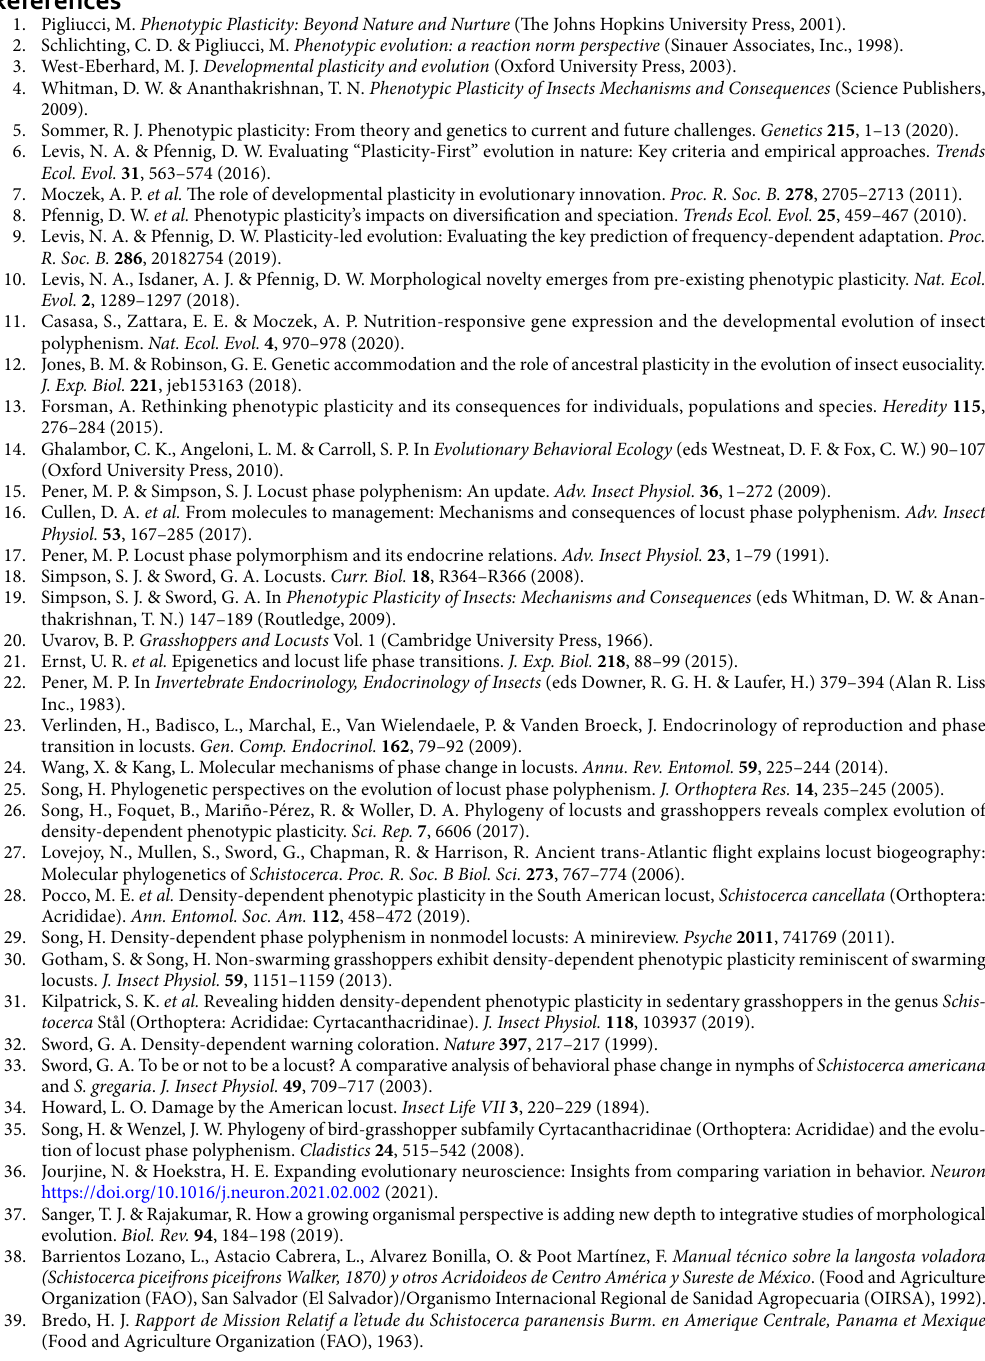
Table 13. All downstream datasets generated and/or analysed during this study have been published in Dryad Digital Repository [https:// doi. org/ 10. 5061/ dryad. dz08k prwz]. Furthermore, additional information related to methods and analyses are included in Supplementary